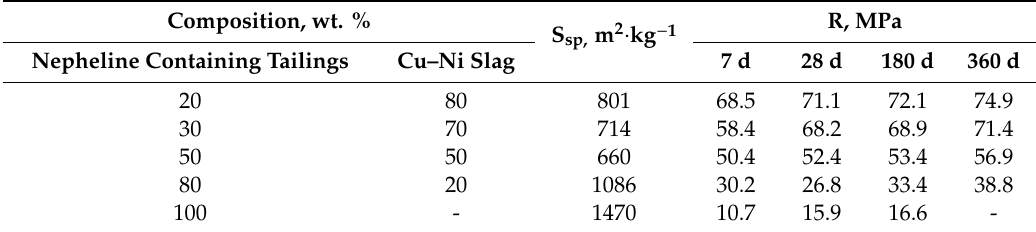
Table 8. The compressive strength (R) of the NT–Cu–Ni slag–liquid glass binder. MA was carried out in CO 2 for 270 s. Liquid glass contained 3.5 wt. % Na 2 O relative to weight of (NT + Cu–Ni slag) mixture; silica modulus of liquid glass was 1.59. Curing was carried out under relative humidity of 95 ± 5% at temperature of 20–22 ◦ C. Water to solid ratio was 0.23; S sp : the specific surface area of the NT–Cu–Ni slag mixture. Composition, wt.